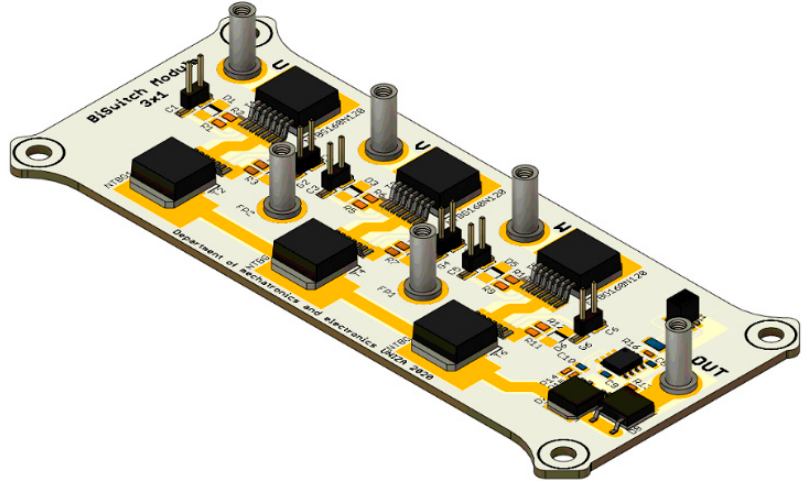
Figure 5. The 3D model of the power board.